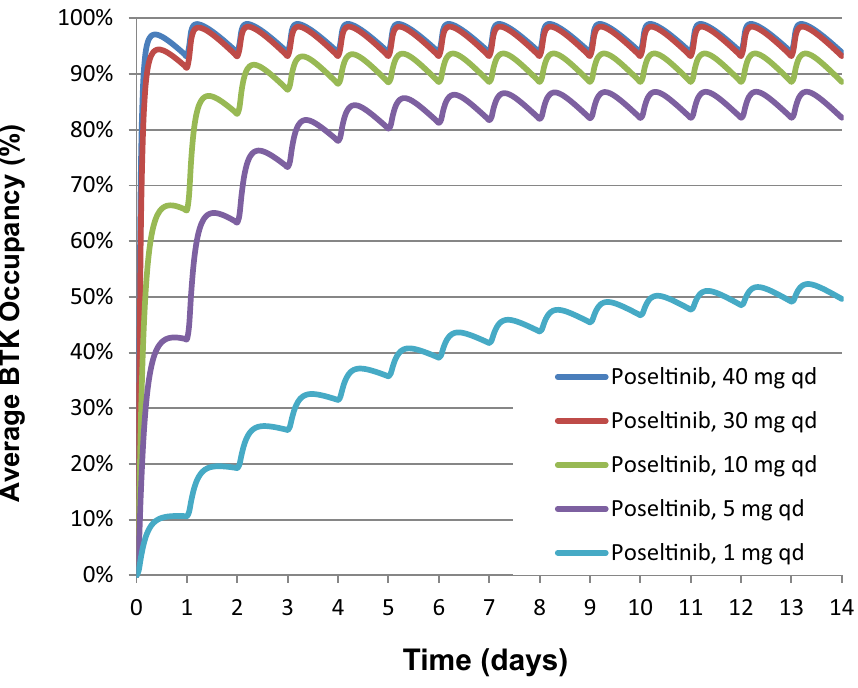
Figure 7. Simulations based on the PK/PD model constructed from phase I trial data from human volunteers illustrating predicted occupancy as a function of time for 1 to 40 mg QD doses of